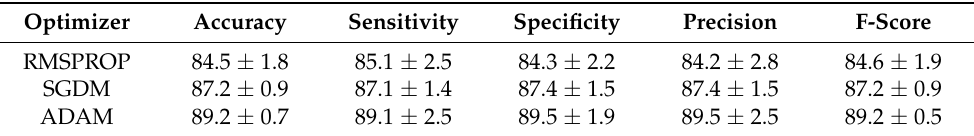
Table 3. Percentage of accuracy, sensitivity, specificity, precision, and F-score ( ± standard deviation) of 10-folds cross-validation for binary classification.